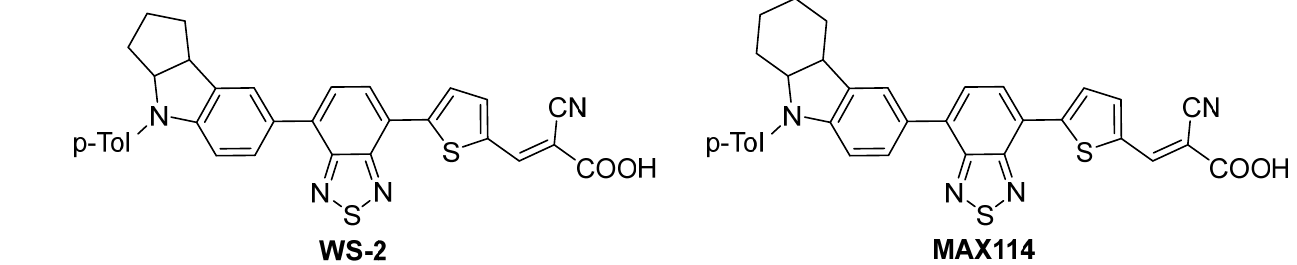
Table 5. UV-Vis absorption characteristics of the КЕА dyes, WS-2 , and MAX114 .